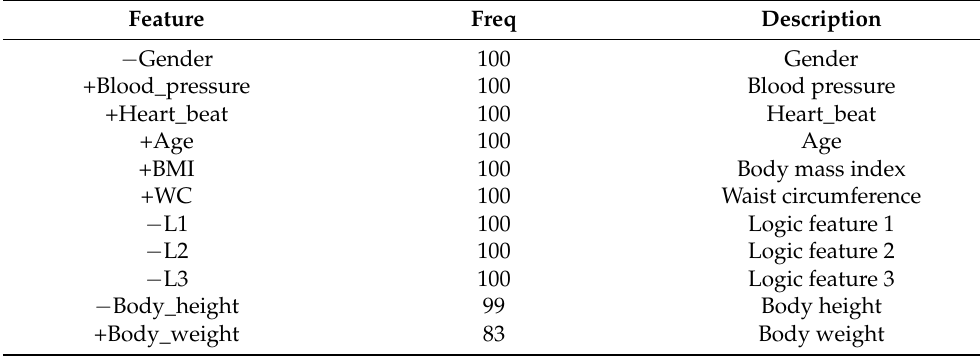
Table 3. Selected features with the Least Absolute Shrinkage and Selection Operator (LASSO) on the dataset with numeric and logic features.